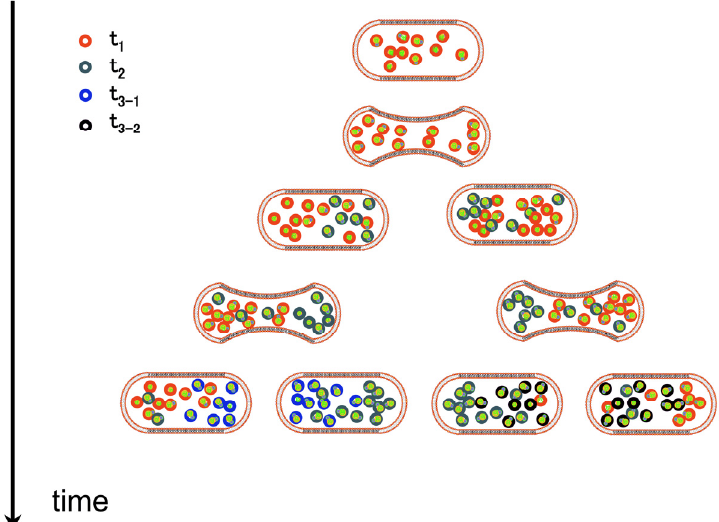
Figure 2. Distribution of proteins of different ages as cells multiply. At the onset of growth the cell is supposed to have all of its proteins of a given type of identical age (red circles). As time elapses some proteins begin to age (green, then blue and purple circles) and are replaced by young ones (red circles). At some point all cells display a mixture of the same protein carrying scars marking their different